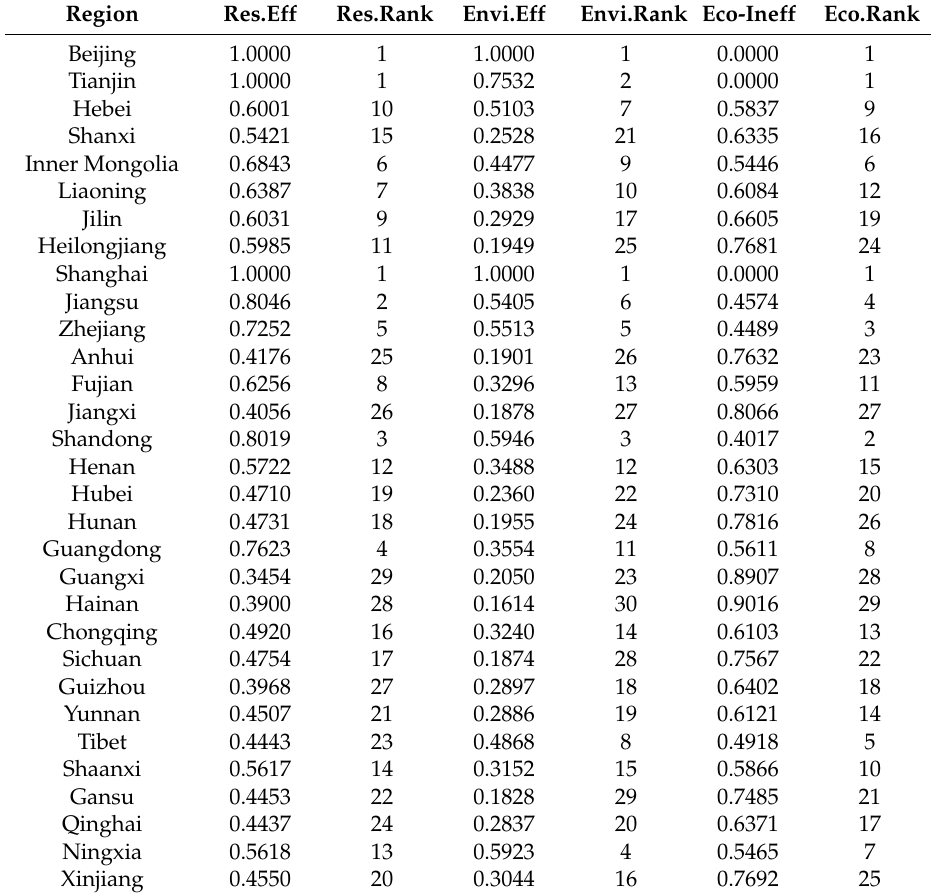
Table 3. Resource efficiency and environmental efficiency (CCR model) and eco-inefficiency (model 3).